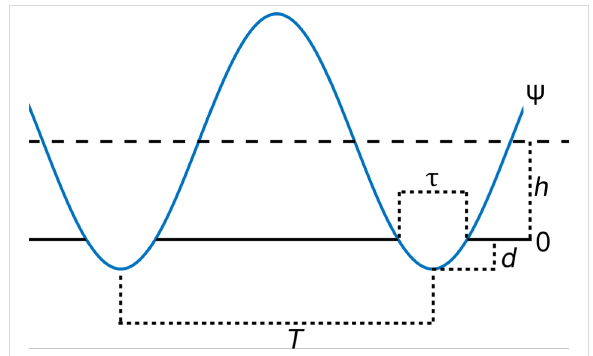
Figure 3: Illustration of the intermittent-contact interaction case. The blue line represents ψ , the trajectory of the tip about the equilibrium position of the cantilever, while the solid black line represents the sur- face position, fixed at reference point zero. h is the cantilever rest posi- tion, T is the fundamental period of the tip trajectory, d is the indenta- tion, and is the contact time.